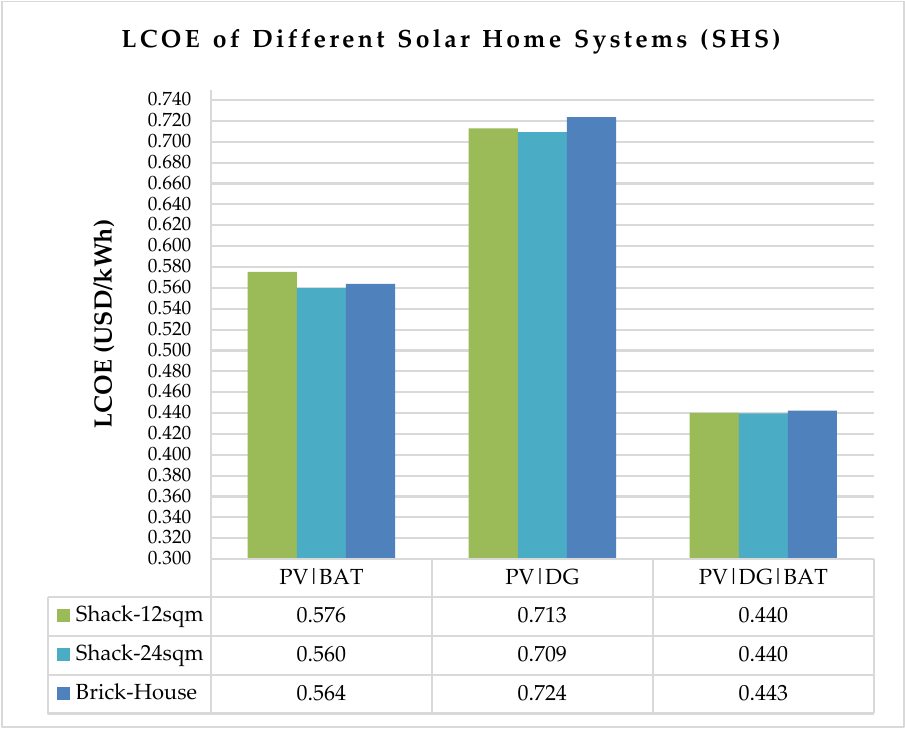
Figure 13. Comparing LCOE of different solar home systems.